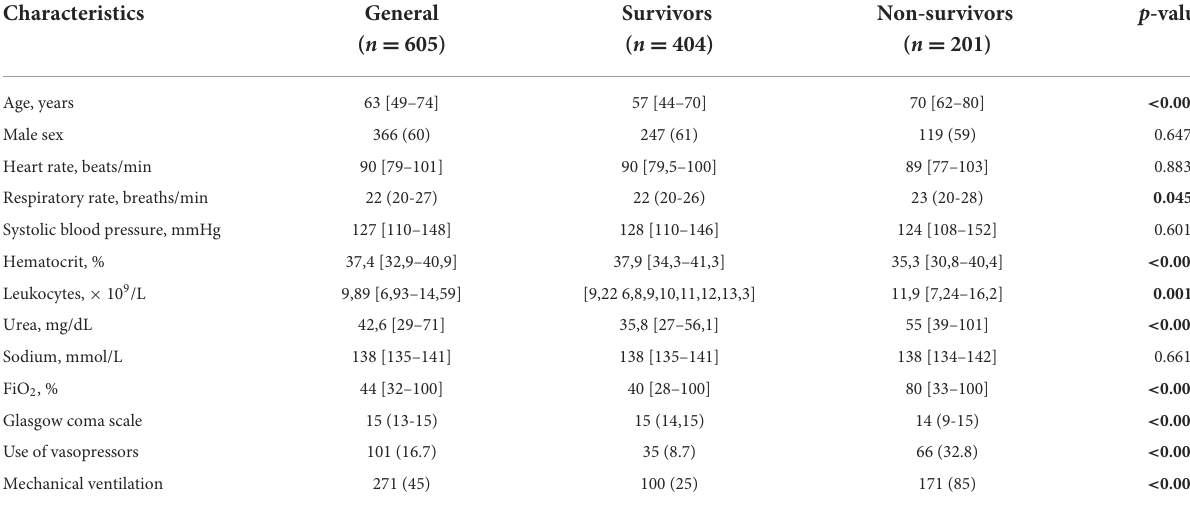
TABLE 1 General population description and comparison between survivors and non